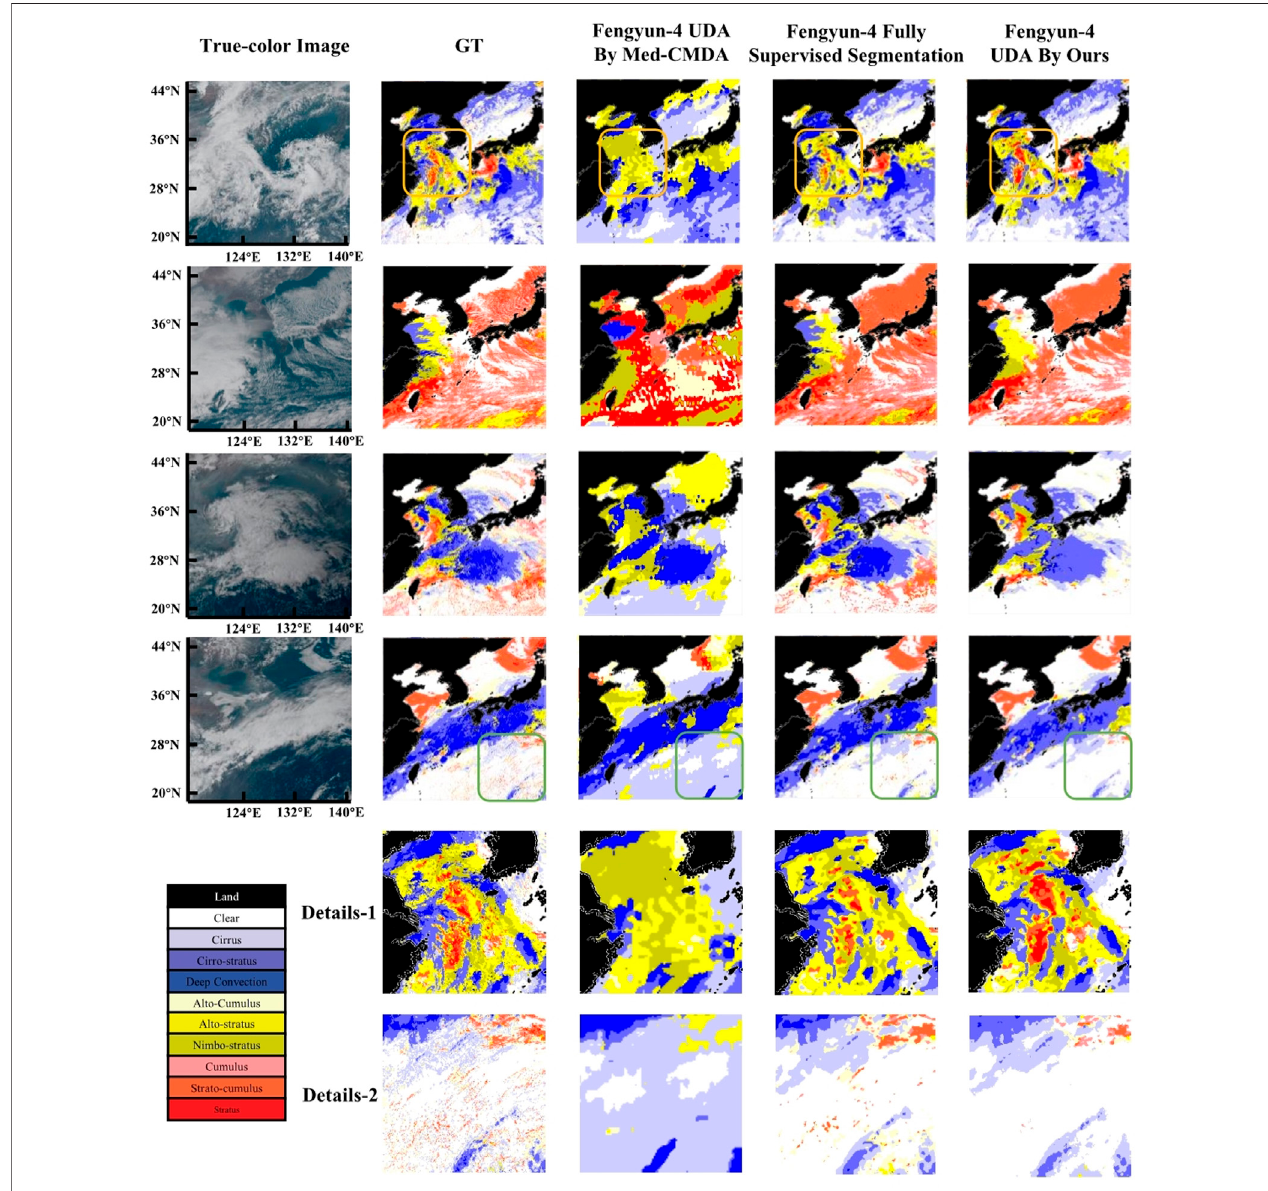
FIGURE 6 | Results of